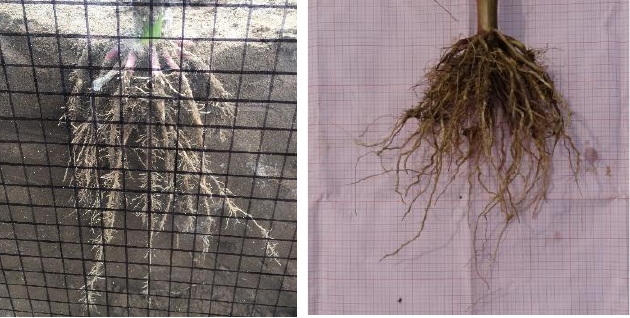
Figure 3. The transparent plastic plate with a square scale .